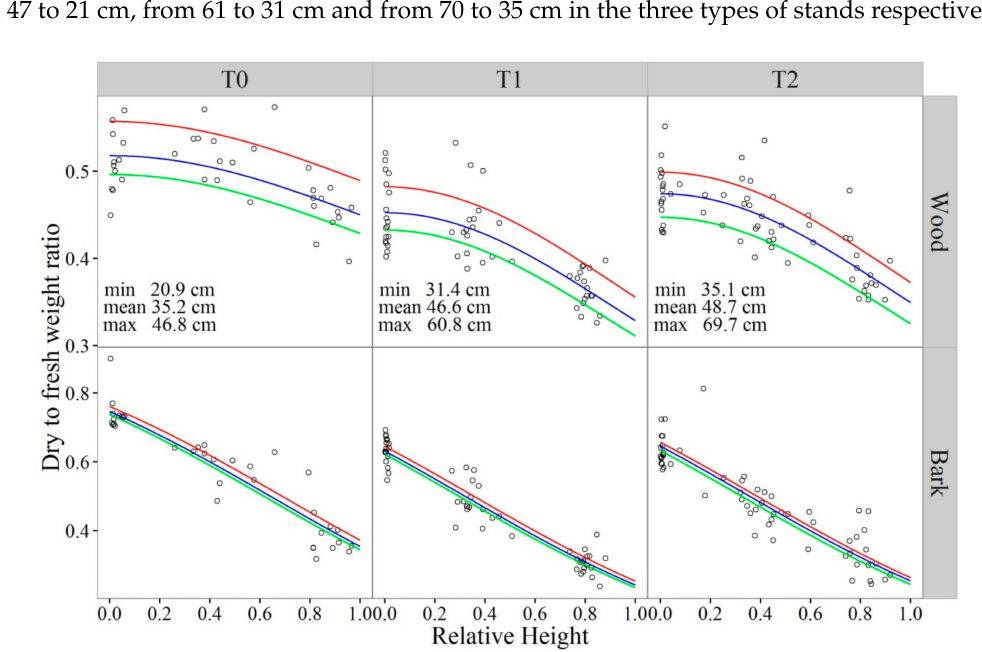
Figure 3. Dry to fresh weight ratios in relation to relative height for stemwood and bark of sample discs from stands under the three thinning regimes. The three curves from top down in each panel represent the estimated values from Equations (1) and (2) for stemwood and bark for the minimum, mean and maximum DBHOB of sample trees from which discs were sampled in each stand type. Table 2. Estimated parameters, their standard errors (SE) and pseudo-R 2 of the dry to fresh weight ratio Equations (1) and (2) which were fitted using beta regression for stemwood and